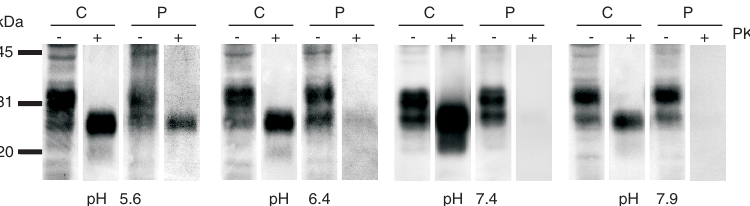
Figure 2. Influence of pH on the resistance of PrP Sc to proteinase K (PK) after pressure treatment. Immunoblot detection of native hamster PrP Sc with the antibody 3F4. C = control; P = treated at 800 MPa, 60 º C, for 120 min in phosphate-buffered saline, pH 5.6, 6.4, 7.4, and 7.9. Samples were incubated with (+) or without (-) PK.